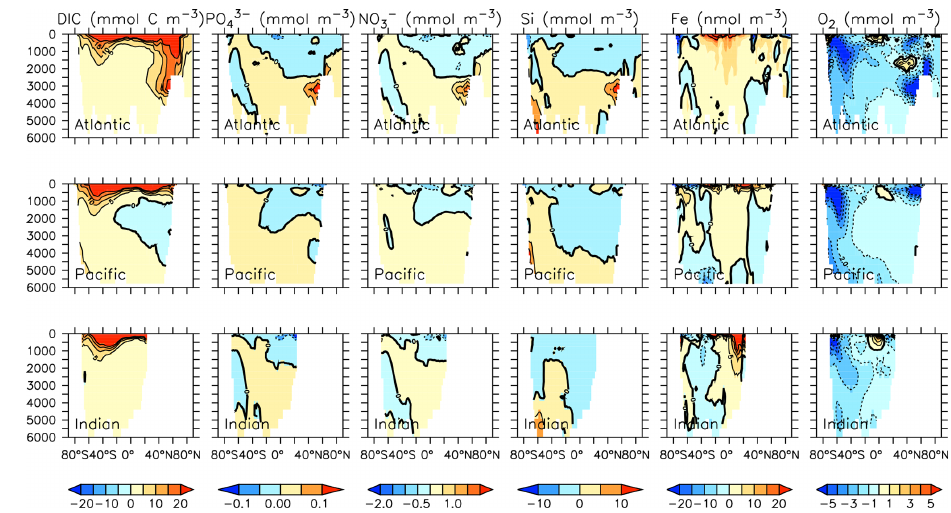
Figure 22. Modelled change in carbon and nutrient profiles by major ocean basins from 1964 to 2014.